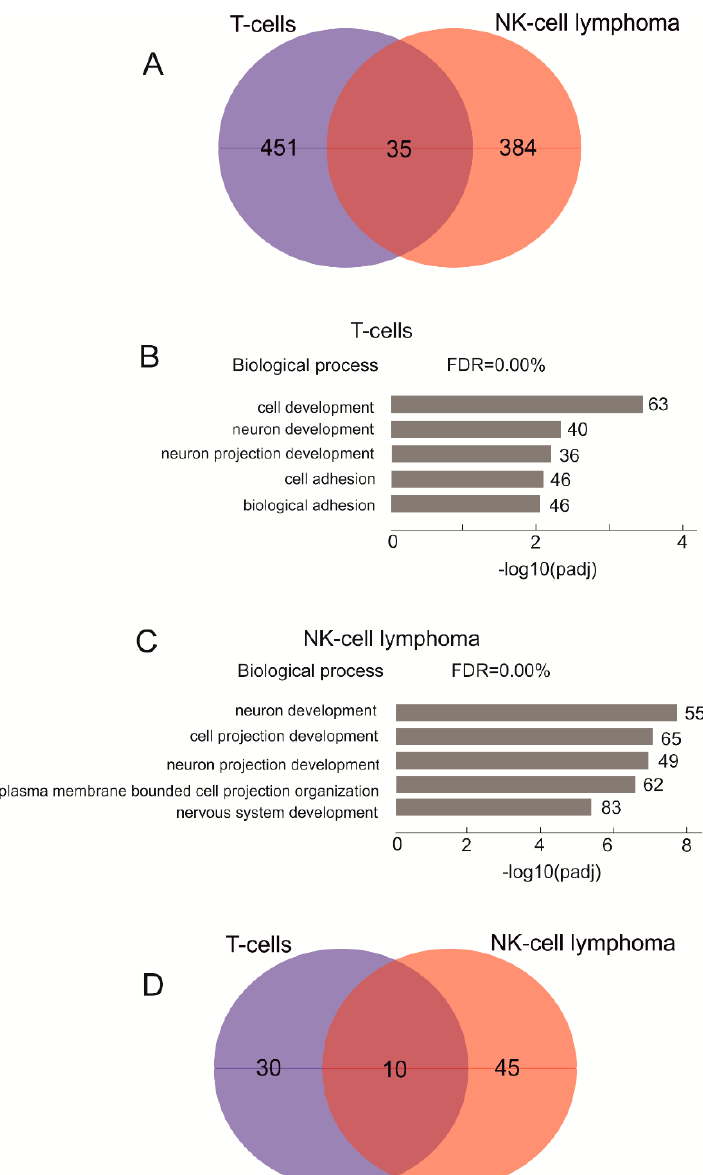
Figure 2. Analysis of genes located at translocation sites in T cells and NK ‐ cell lymphomas. ( A ) a Venn diagram showing the intersections between genes at translocation sites in T cells and NK ‐ cell lymphomas. Table S2 shows the list of over ‐ lapping genes. ( B ) the top five Gene Ontology biological process associations of genes shown in ( A ) that correspond to the affected genes in T cells. The values to the right of the bars show the number of genes associated with a process. Table S3 shows the results of the corresponding GO search. ( C ) the top five Gene Ontology biological process associations of genes shown in ( A ) that correspond to the affected genes in NK ‐ cell lymphomas. The values to the right of the bars show the number of genes associated with a process. Table S4 shows the results of the corresponding GO search. ( D ) a Venn dia ‐ gram showing the intersections between genes corresponding to GO item GO:0048666 (neuron development) at translo ‐ cation sites in T cells and NK ‐ cell lymphomas.